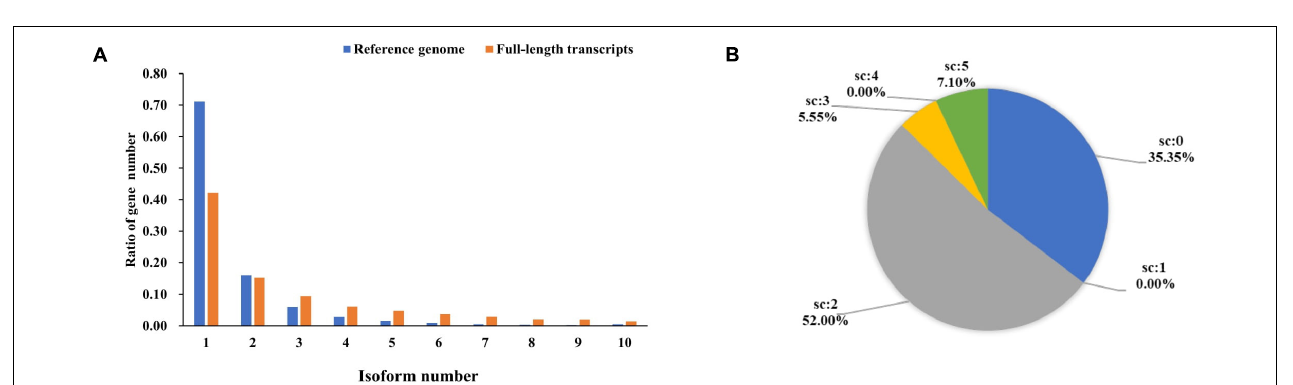
FIGURE 3 | (A) Length distribution and full-length transcripts of lncRNAs in abdominal and subcutaneous adipose. (B) The number of DET of lncRNA in abdominal adipose and subcutaneous at each time point.